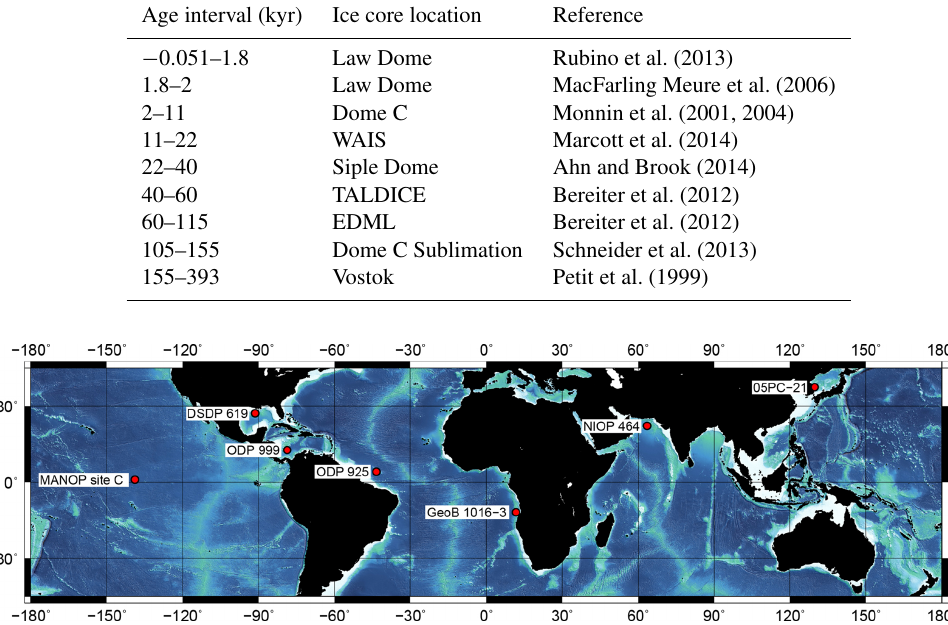
Figure 1. Site map with locations of sites discussed the